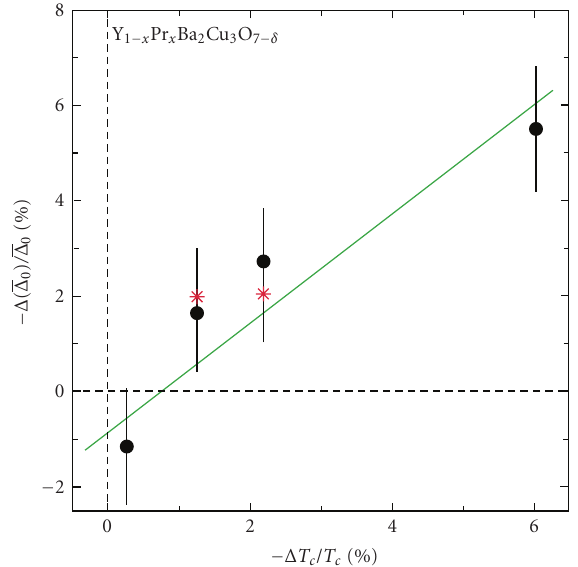
Figure 6: Comparison of the OIE shift of the average supercon- ducting gap Δ 0 to the one on the transition temperature T c for Y 1 − x Pr x Ba 2 Cu 3 O 7 − δ ( x = 0.0, 0.2, 0.3, 0.45). Circles refer to the experimental data. The stars represent back exchange data. The solid green line is discussed, after [17]. Y 1 − x Pr x Ba 2 Cu 3 O 7 − δ by means of μ SR and